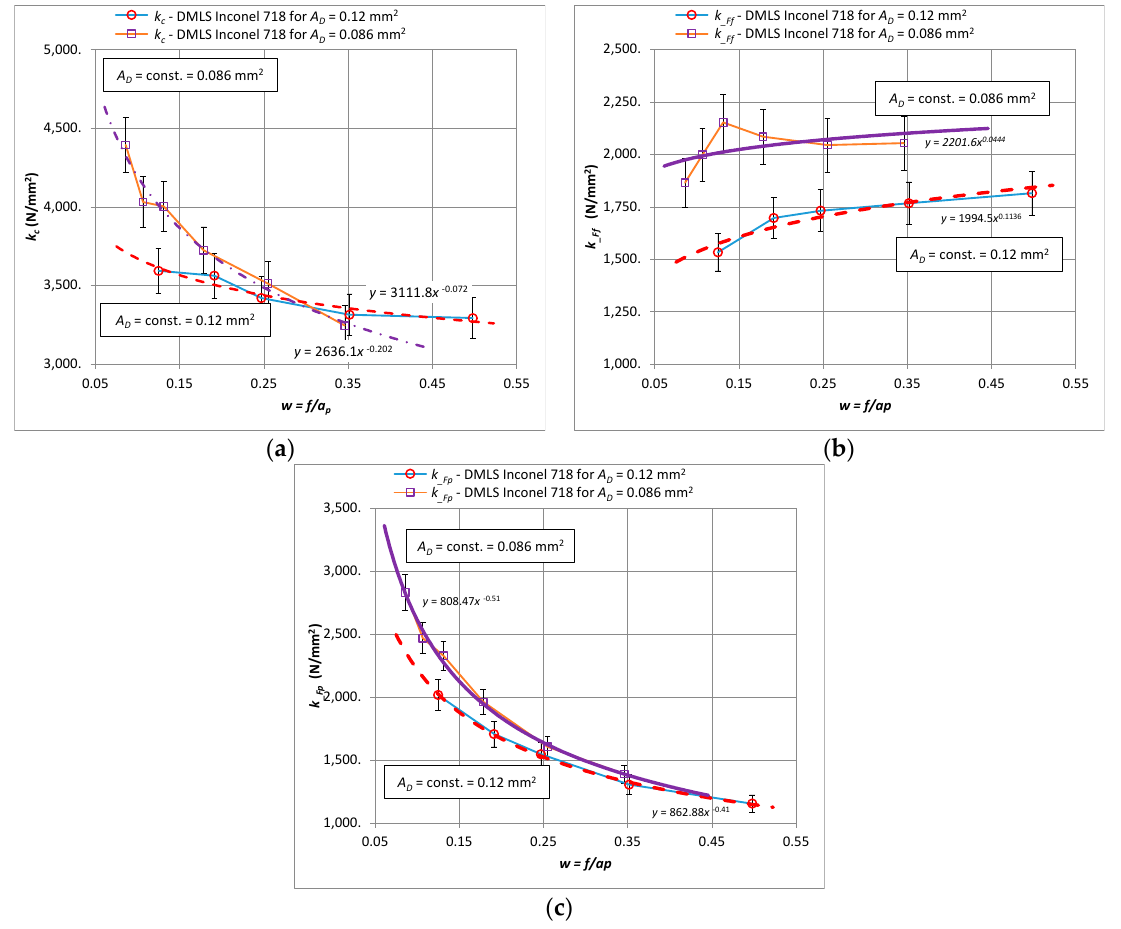
Figure 6. Relationships for specific cutting force components F c , F f , F p for turning with a constant cross-section of the cutting layer A D = 0.8 mm 2 and A D = 1.2 mm 2 for 3D printed Inconel 718, ( a ) k c , ( b ) k _Ff , ( c ) k _Fp .